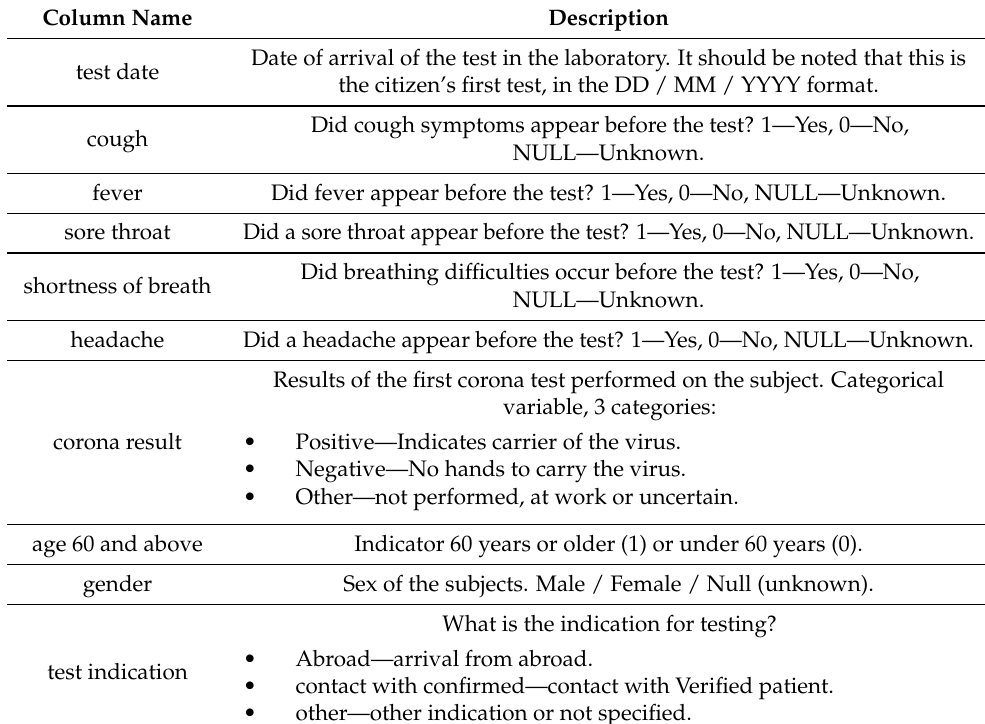
Table 3. Dataset